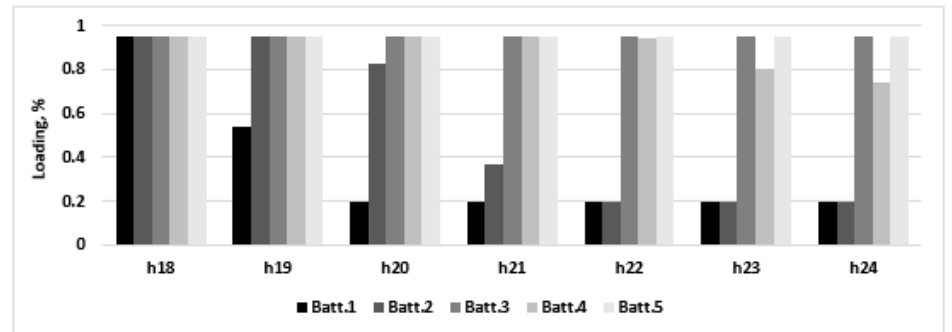
Figure 8. The discharge pattern for the batteries, Scenario 1.